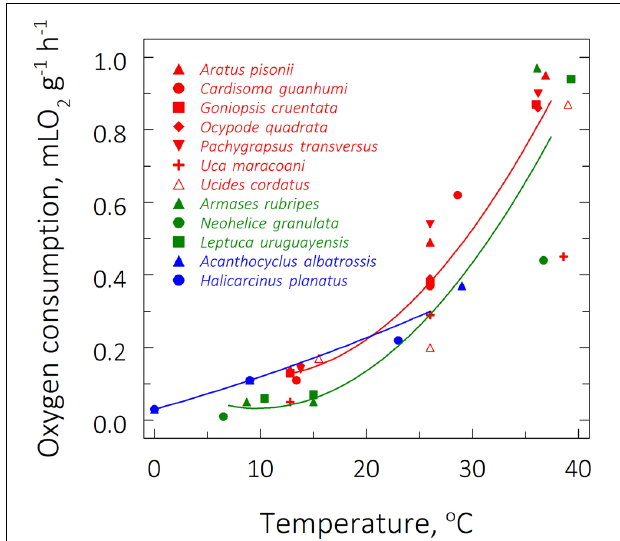
FIGURE 2 | Effect of direct transfer of tropical (red), subtropical (green), and sub-Antarctic (blue) crab species on mass-specific oxygen consumption rate (QO 2 ) after 6 h exposure to their respective upper and lower critical thermal limits, from their corresponding field reference temperatures of 26, 15, and